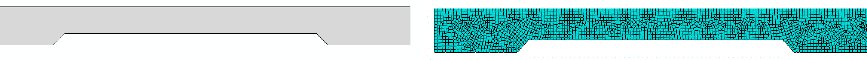
Figure 8. The two-dimensional axisymmetric model and meshing.